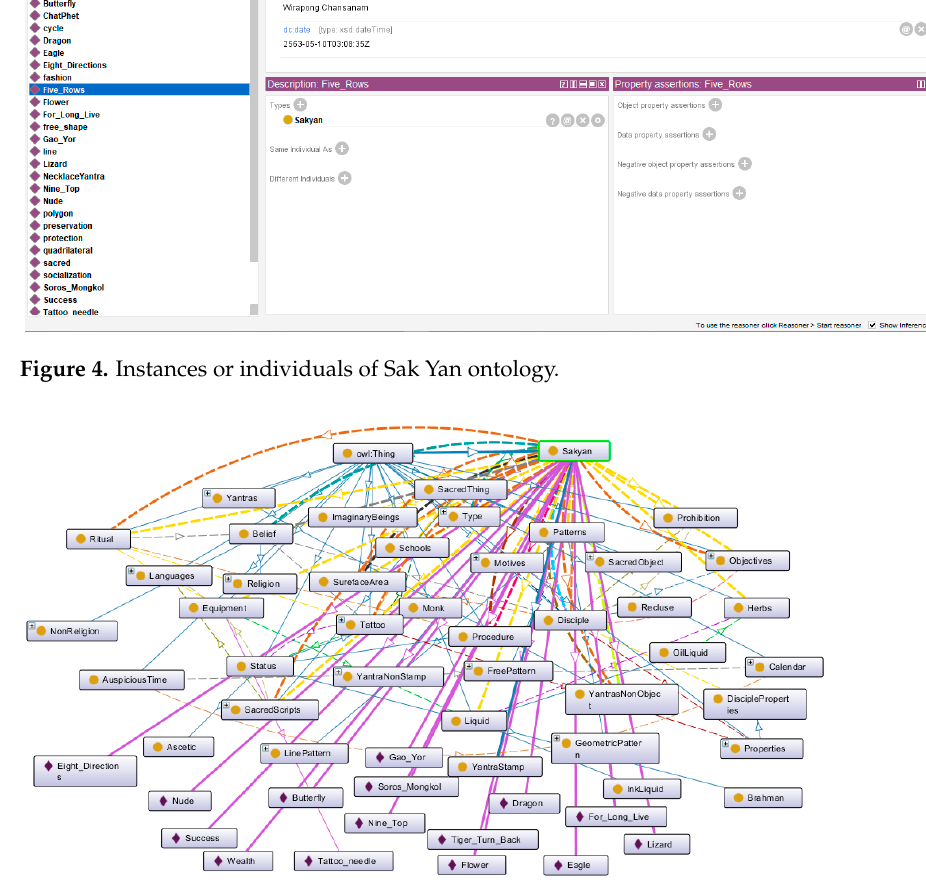
Figure 5. Sak Yan ontology visualization by Onto Graf.